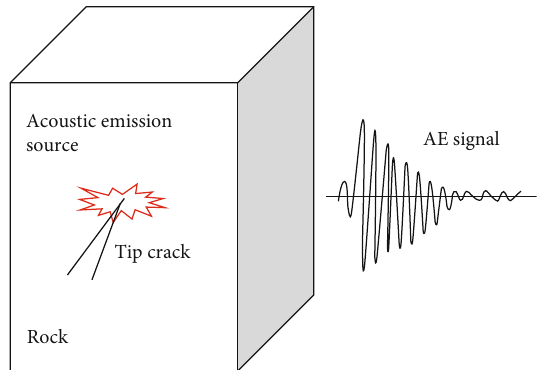
Figure 7: AE signal generation principle and its characteristic